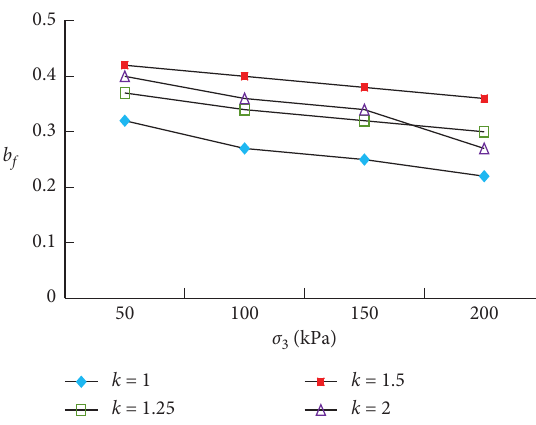
Figure 11: Change law between σ